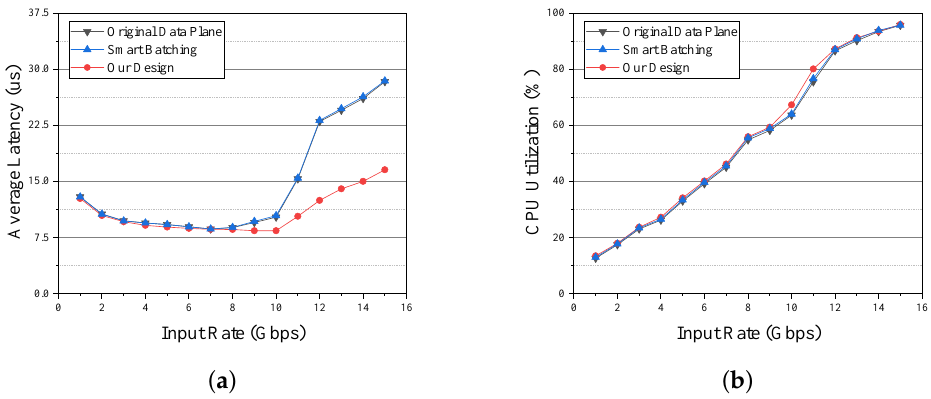
Figure 12. The performance of each scheme on single queue scenario. ( a ) The average latency of each scheme under different input rates. ( b ) The CPU utilization of each scheme under different input